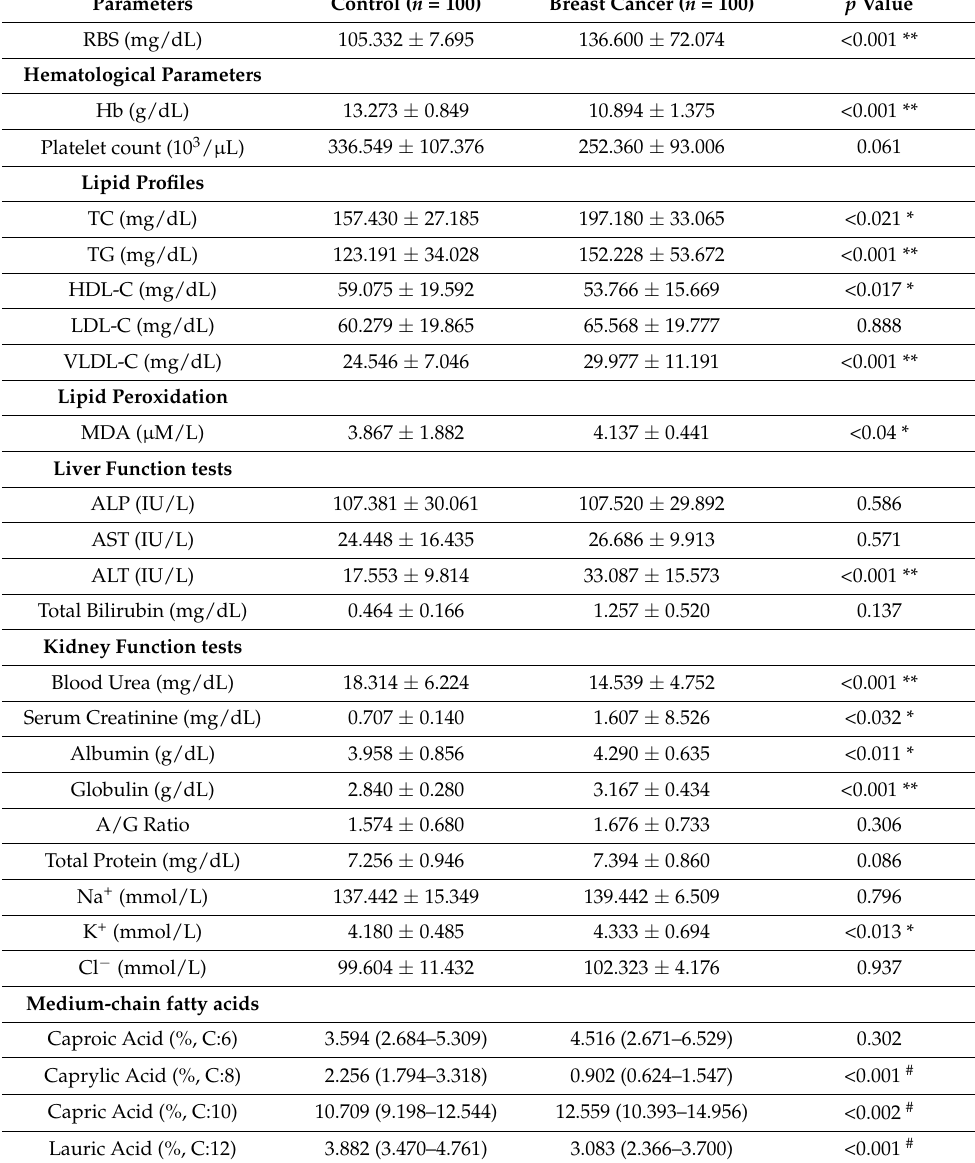
Table 3. Comparison of the biochemical parameters in subjects with and without breast